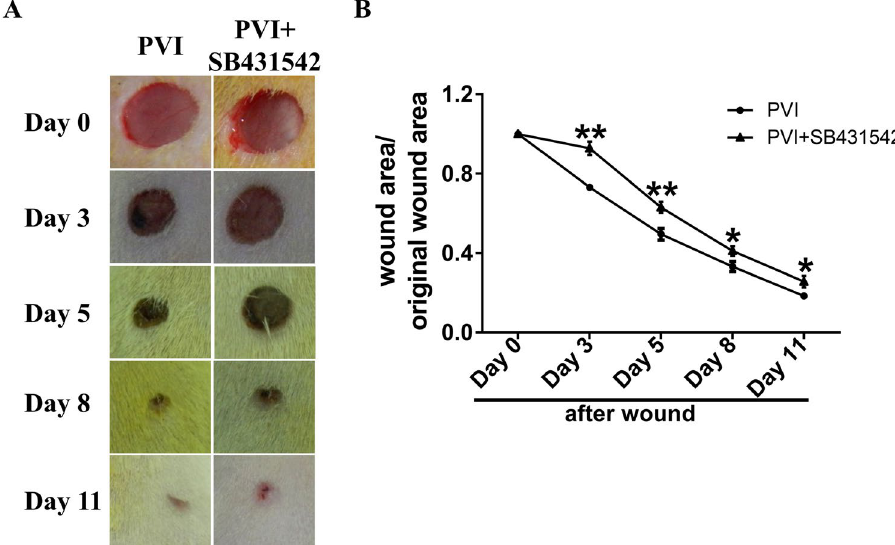
Figure 8. Inhibition of transforming growth factor β prevented the promotion of skin wound healing by Povidone-iodine (PVI) treatment. ( A ) Representative photographs of wounds from rats treated with inhibitor of transform growth factor β (SB431542) or vehicle and PVI. ( B ) Wound contraction (%) at day 1 to 11 post- injury. * p < 0.05, ** p < 0.01 vs control. Data are means ± S.D, n =